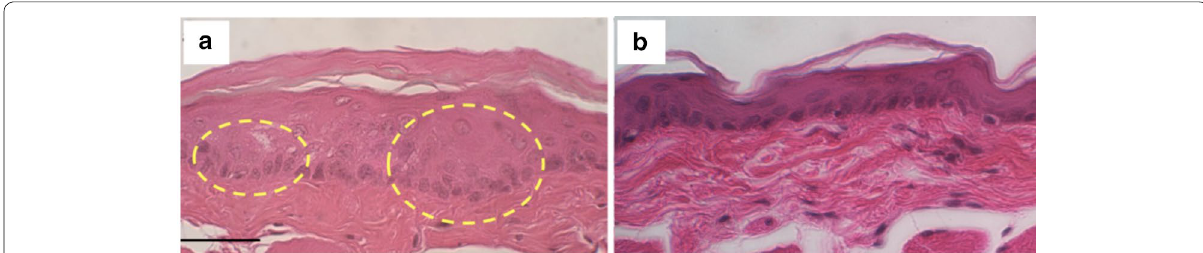
Fig. 6 H&E stained dysplastic hamster cheek pouch tissue topically administered with acid‑disassembling Au NCs ( a ) and normal hamster cheek pouch tissue ( b ). Dotted circles indicate thickened epithelial layers indicating early‑stage dysplasia. Scale bar: 100